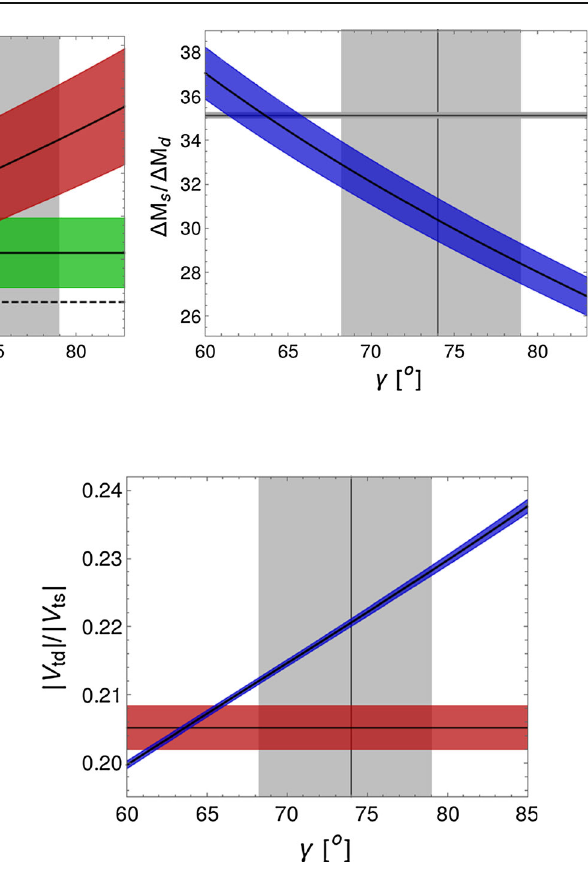
Fig. 5 The ratio | V td | / | V ts | as function of the angle γ . In blue we show the prediction from Eq. (23), to be compared with the result of (24) displayed in